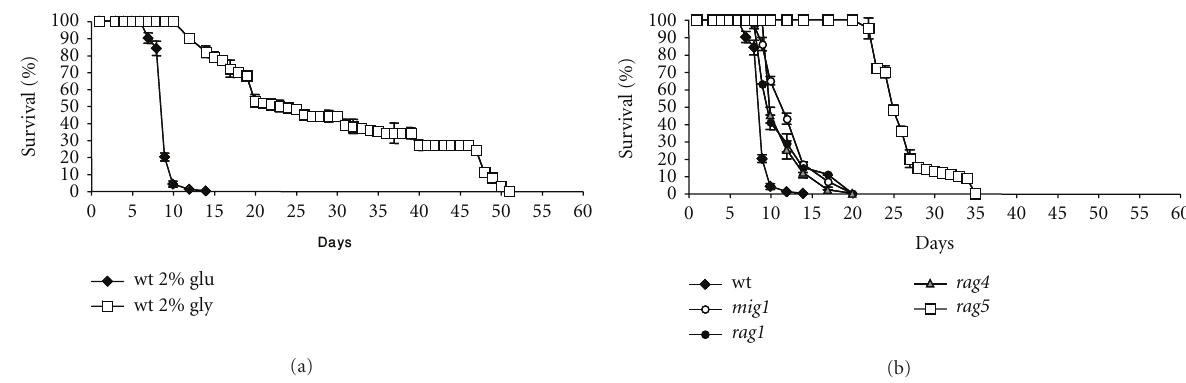
Figure 1: Chronological lifespan of yeast K. lactis . (a) Comparison of chronological survival of wild type JA6 grown in either glucose 2% and glycerol 2%. (b) Comparison of chronological survival in YPD medium of wild type strain and several mutants in glucose repression pathway. For each analysis (a, b) aliquots of cultures were counting over time and serial dilutions were plated on solid medium. Colony forming units were counted after 3 days. Data are representative of at least three independent experiments, mean ± s.d.